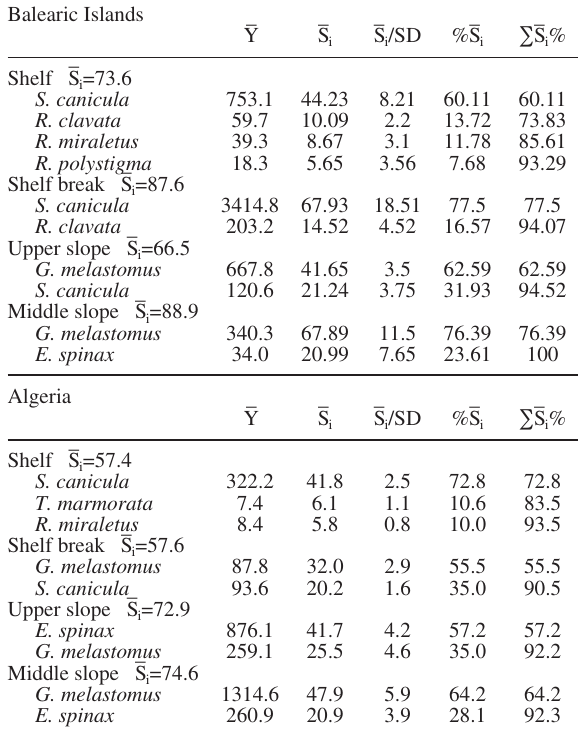
Table 4. – SIMPER results for each elasmobranch assemblage identified in each area from cluster analysis. S– (kg km -2 ); , average similarity; SD, standard deviation; %S i centage contribution to the similarity. Balearic